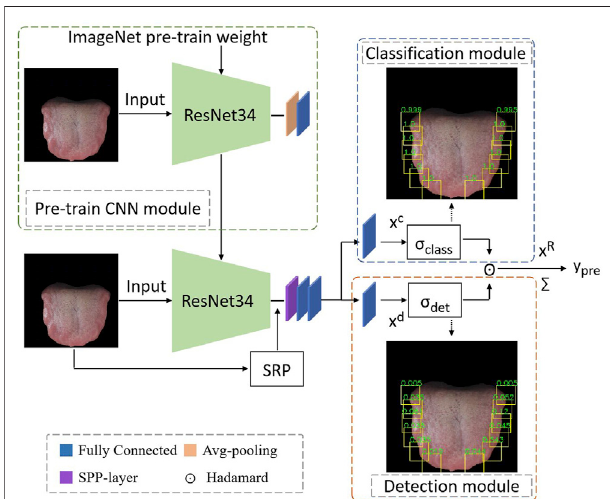
FIGURE 3 | Framework of the proposed method. It includes a pre- trained CNN module; an SRP module for generating tooth mark candidate regions; an SPP-layer for obtaining and normalizing the deep features of tooth mark candidate regions; two weakly supervised branches, a classi fi cation module and a detection module; The hadamard operation of the branch results and summation yields the image-level classi fi cation results.